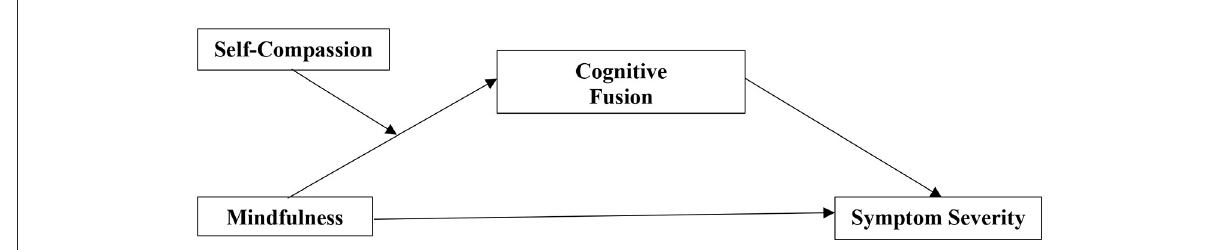
FIGURE1 Moderated mediation model for mindfulness, self-compassion, cognitive fusion, and symptom